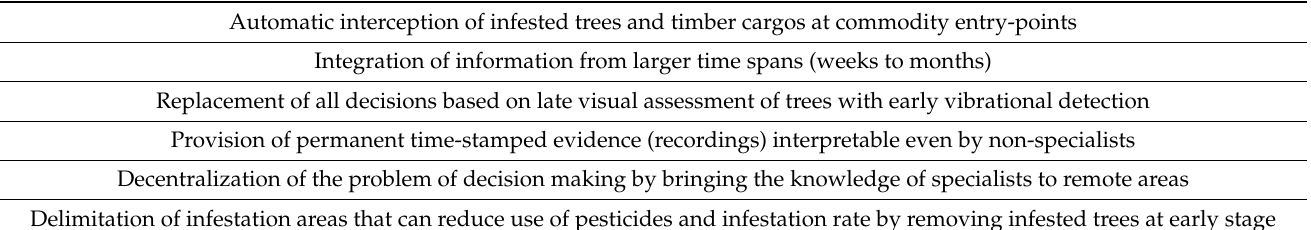
Table 3. A list of benefits using automatic screening of trees’ vibrational records. Automatic interception of infested trees and timber cargos at commodity entry-points Integration of information from larger time spans (weeks to